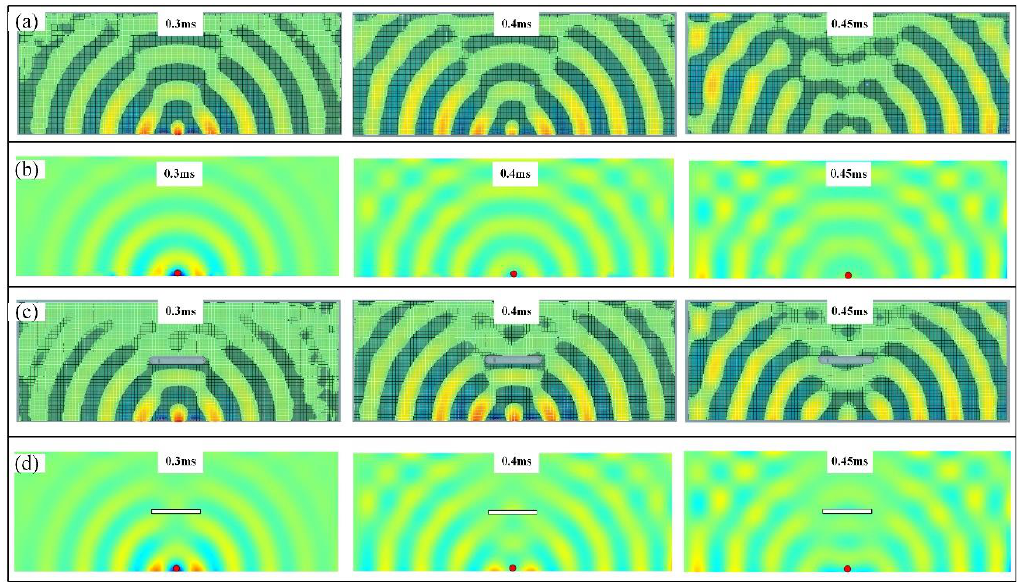
Figure 12. Instantaneous wave field under the surface excitations: ( a ) Experimental results of the intact plate; ( b ) semi-analytical results of the intact plate; ( c ) experimental results of the damaged plate; ( d ) semi-analytical results of the damaged plate.